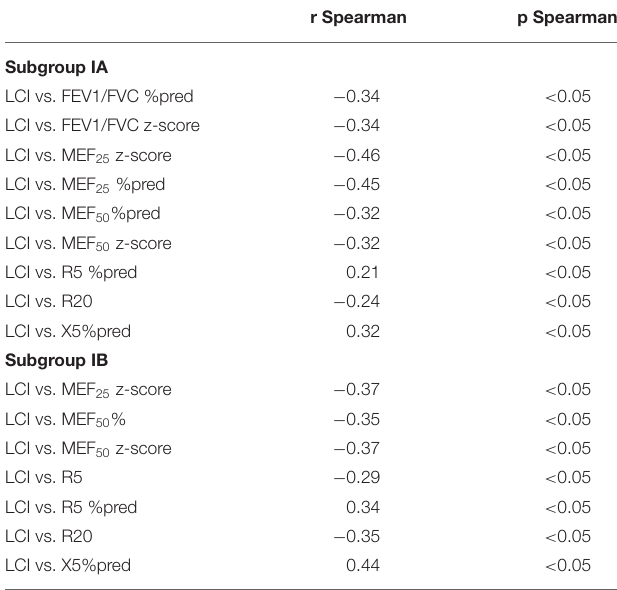
TABLE 4 | Statistically significant diferences in spirometry and IOS parameters in subgroups: subgroup IC (LCI ≤ 7.91) and subgroup ID ( > 7.91). Subgroup IC (LCI ≤ 7.91)